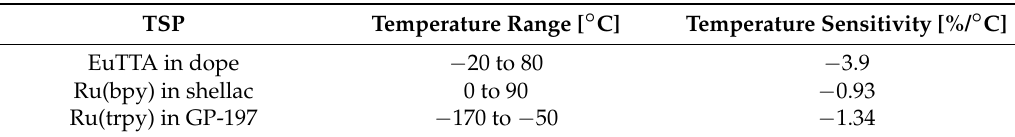
Table 1. Typical temperature-sensitive paint (TSP) sensitivities